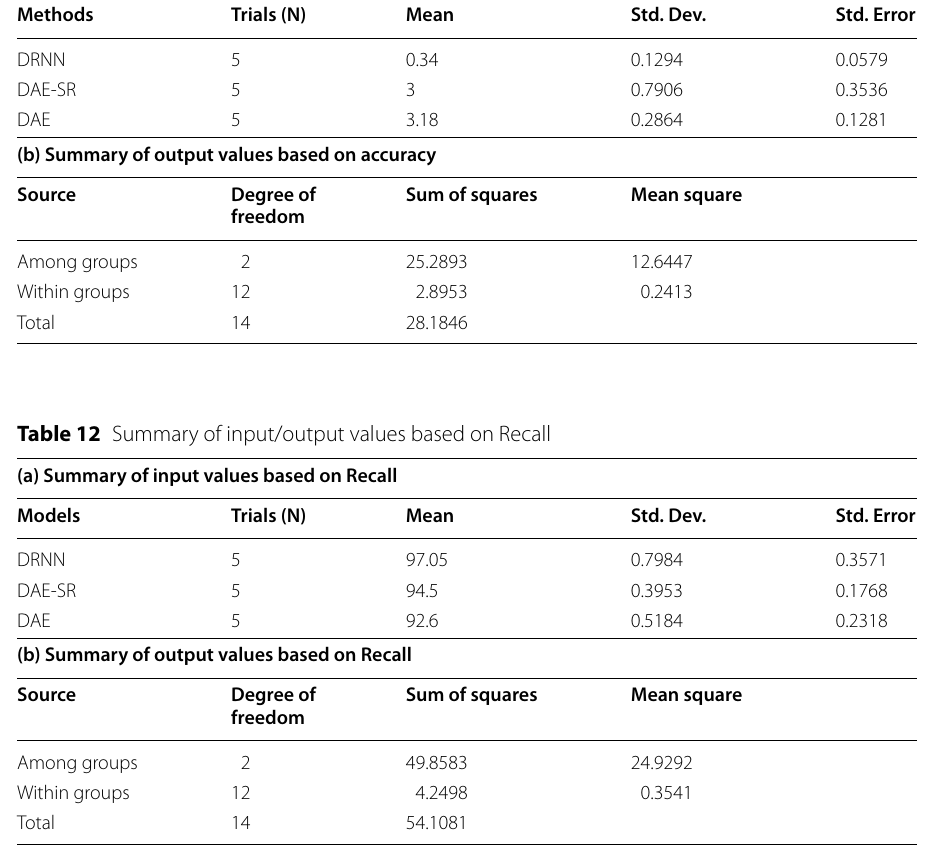
Table 11 Summary of input/output values based on accuracy (a) Summary of input values based on accuracy Methods Trials (N)